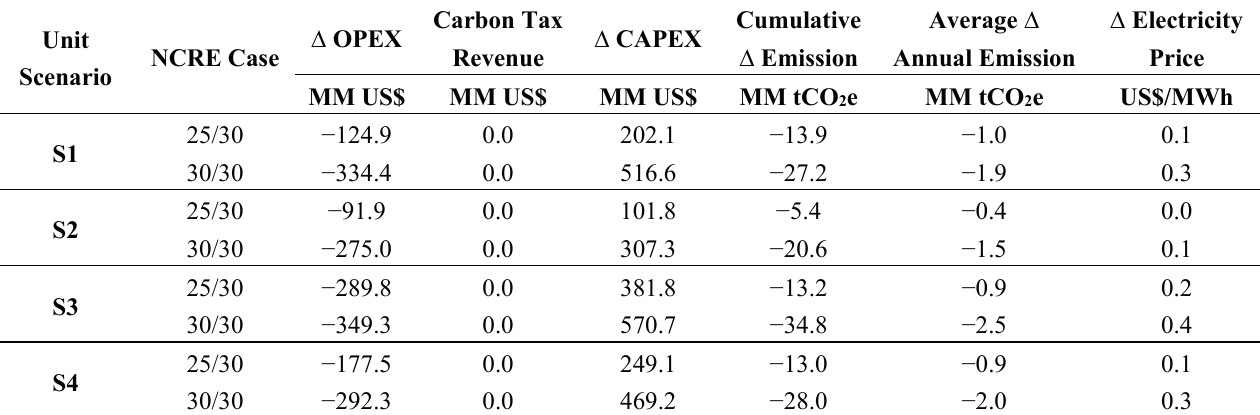
Table 6. Evaluation of a change to the current non-conventional renewable energy law.